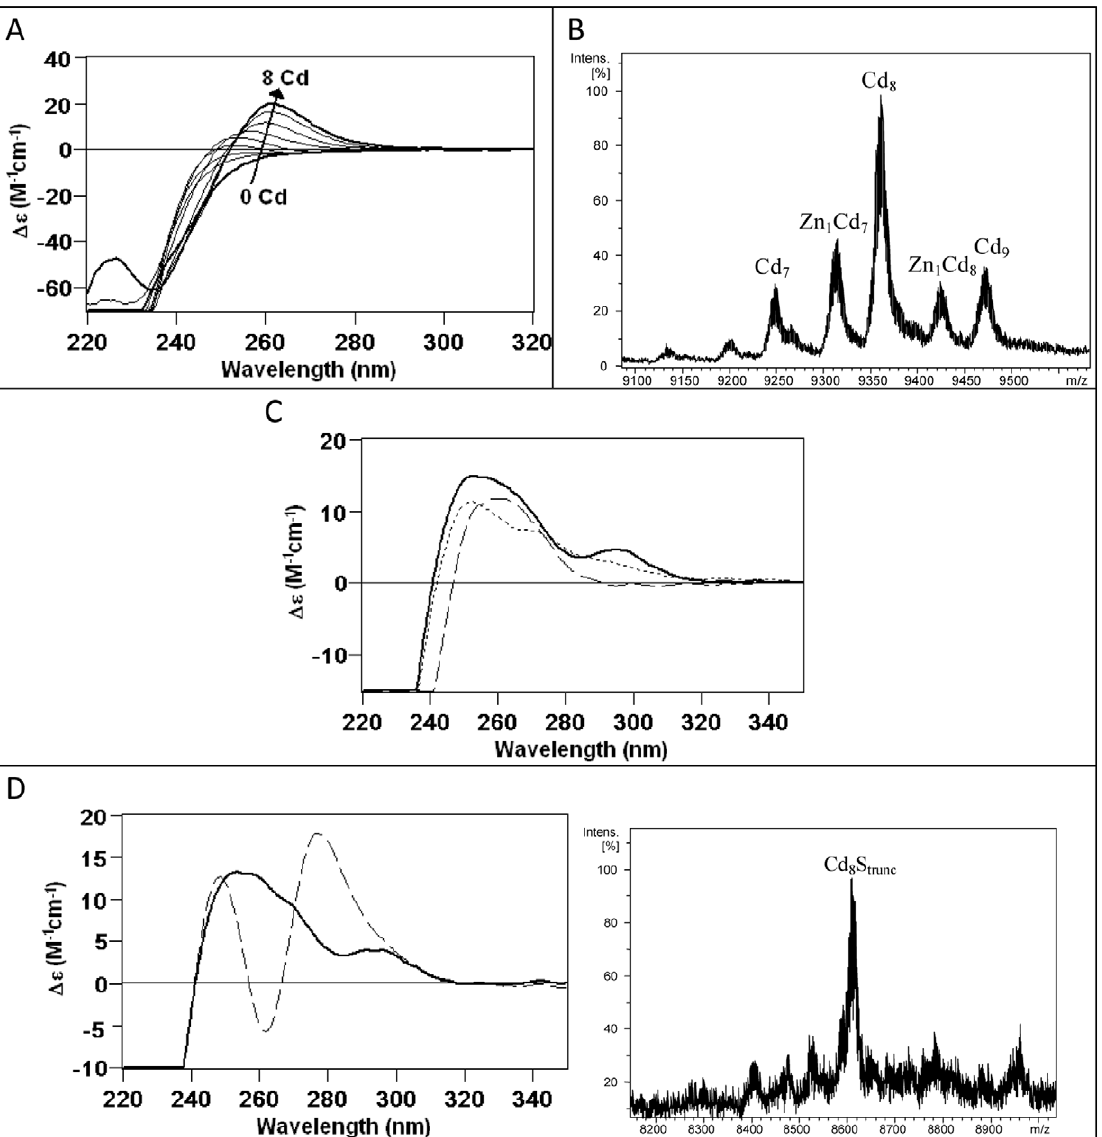
Figure 8. The invitro Cd(II) binding abilities of BfMT1 points to a partial preference for divalent metal ion coordination. (A) CD corresponding to the titration of a 10 m M solution of Zn-BfMT1 with Cd(II) at pH 7.0 until 8 Cd(II) eq added (B) Deconvoluted ESI-MS spectrum of an aliquot corresponding to the addition of 8 Cd(II) eq to Zn-BfMT1. (C) Comparison of the CD spectra of the recombinant Cd-BfMT1 preparation (solid line), the acidified and reneutralized sample (dashed line), and the latter after the addition of 4 S 2 2 equivalents (dotted line). (D) Comparison of the CD spectra of the Cd-BfMT1 sample before (solid line) and after (dashed line) 28-days of evolution under inert atmosphere and ESI-MS spectrum of the final